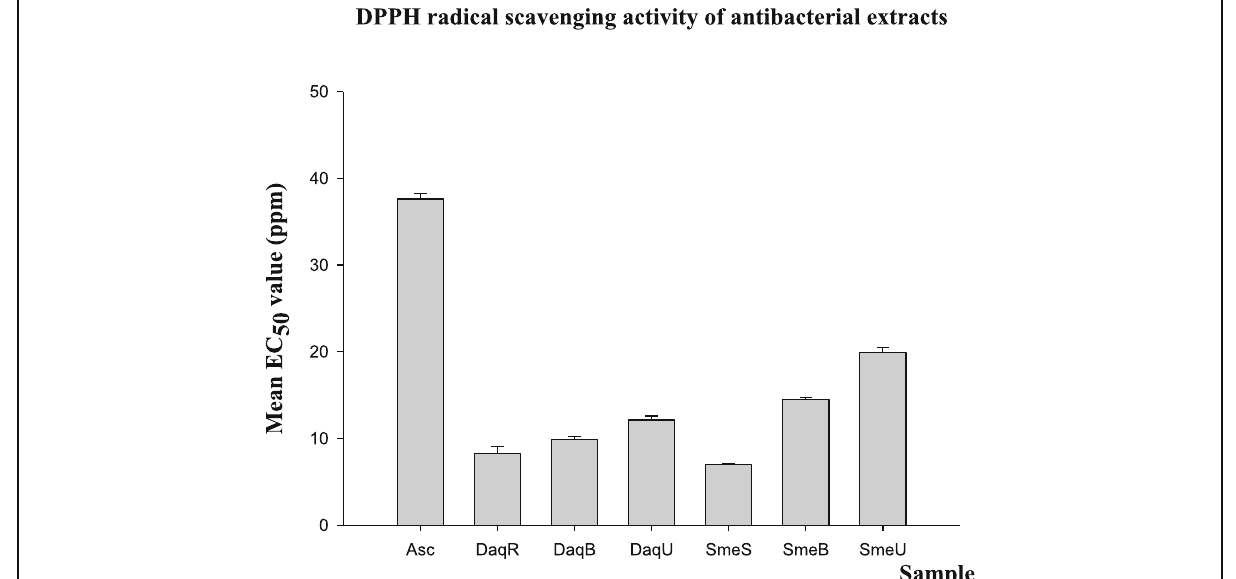
Fig. 5 DPPH radical scavenging activity (EC 50 value) of ascorbic acid and Terminalia bellirica extracts (Sample: Asc, Ascorbic acid; DaqR, direct aqueous extract from reflux method; DaqB, direct aqueous extract from bottle-shaker method; DaqU, direct aqueous extract from ultrasound